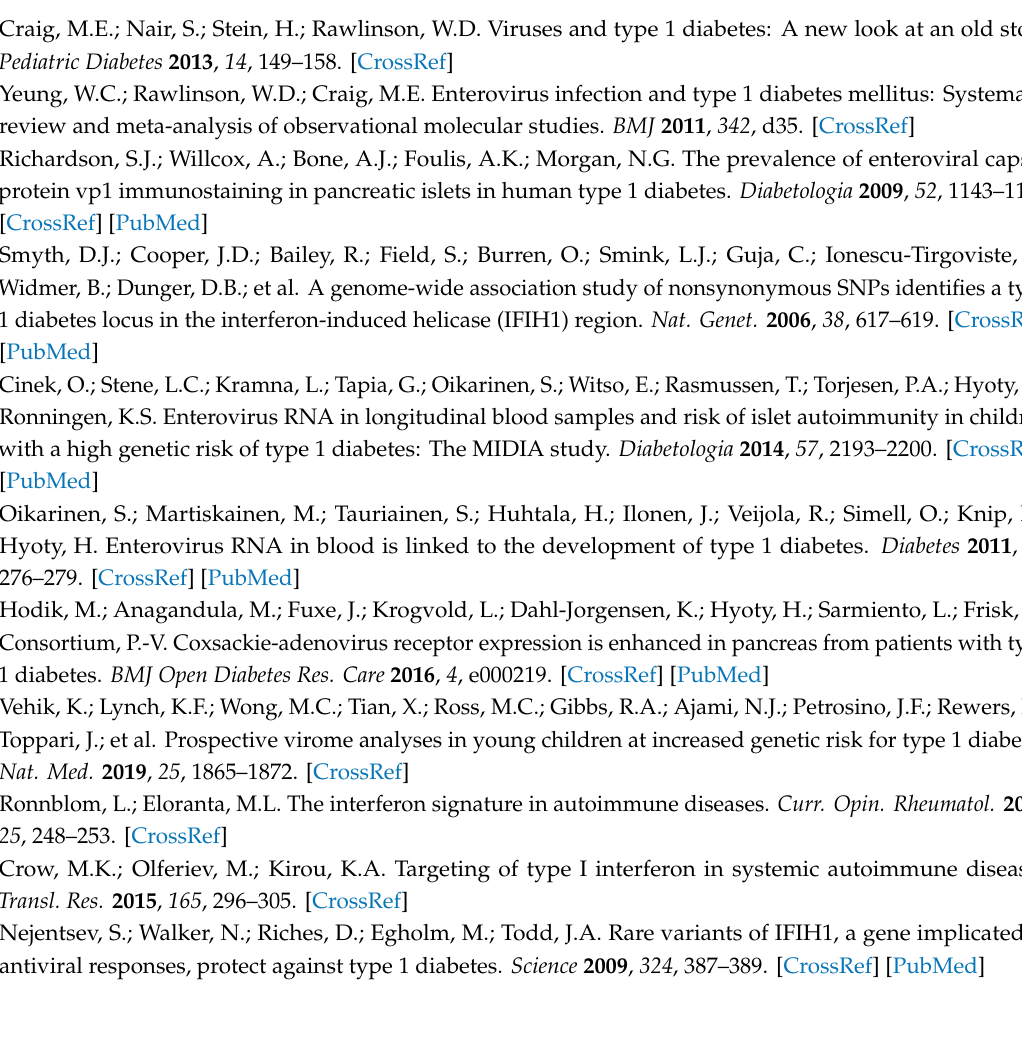
Table S1: Proteins with > 1.5-fold (log2) di ff erence in CVB4-infected compared to uninfected SC- β cells at 72 h. Figure S1: Assessment of perifusion and total insulin in CVB4-infected SC- β cells in an independent experiment from that shown in Figure 5. Table S2: Supplementary data file